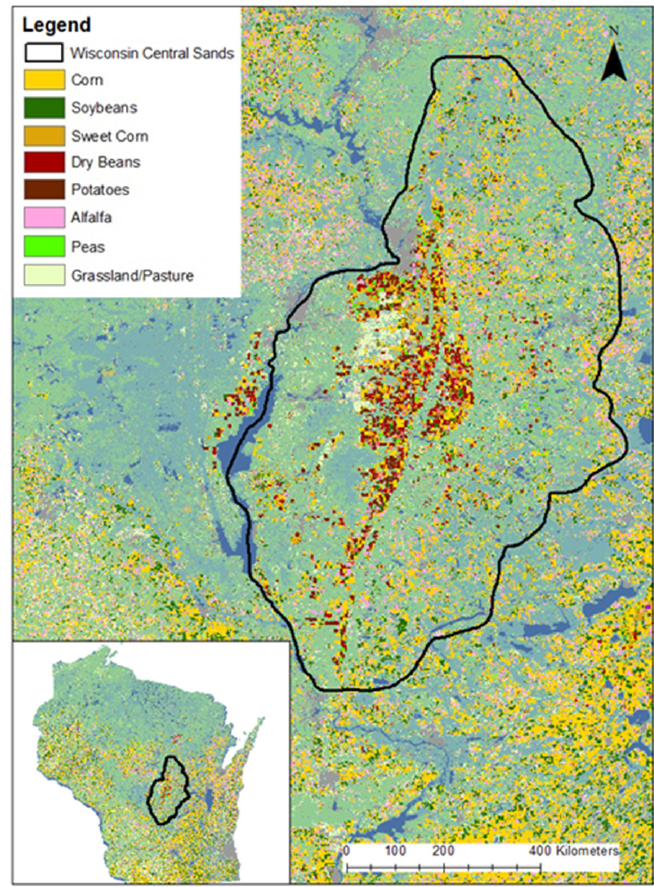
Figure 1. The 2019 USDA Cropland Data Layer (CDL) and dominant crop types found in the Wisconsin Central Sands (dark black outline). This boundary is defined as a contiguous area east of the Wisconsin River with sand and gravel deposits greater than 50 feet deep (Wisconsin DNR).